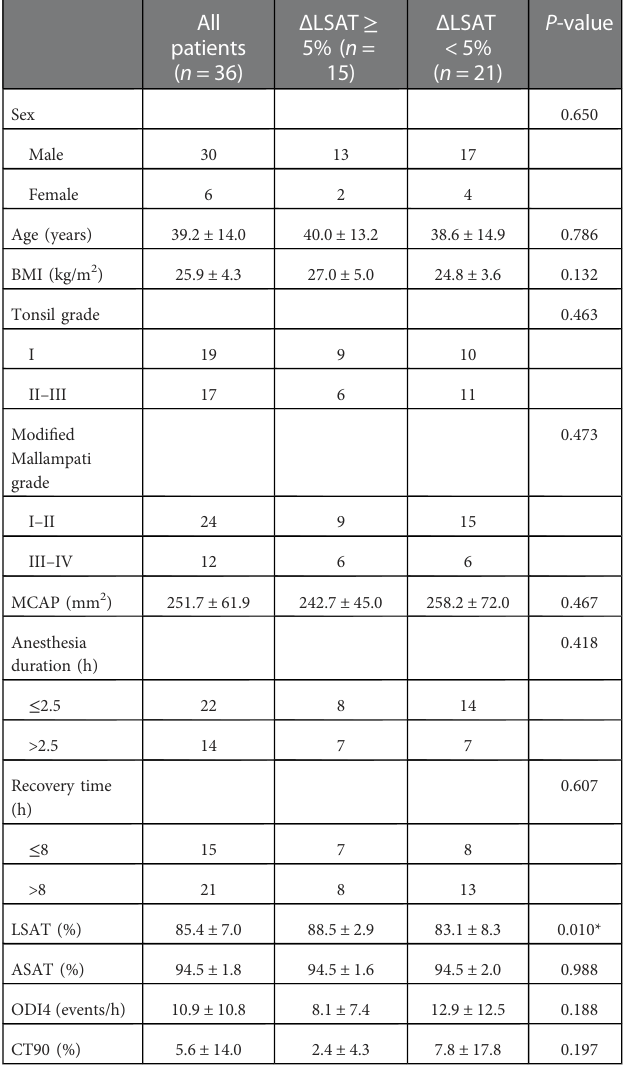
TABLE 2 Comparison of baseline information and pulse oximetry variables of patients in different Δ LSAT groups after bilateral nasal packing. All patients